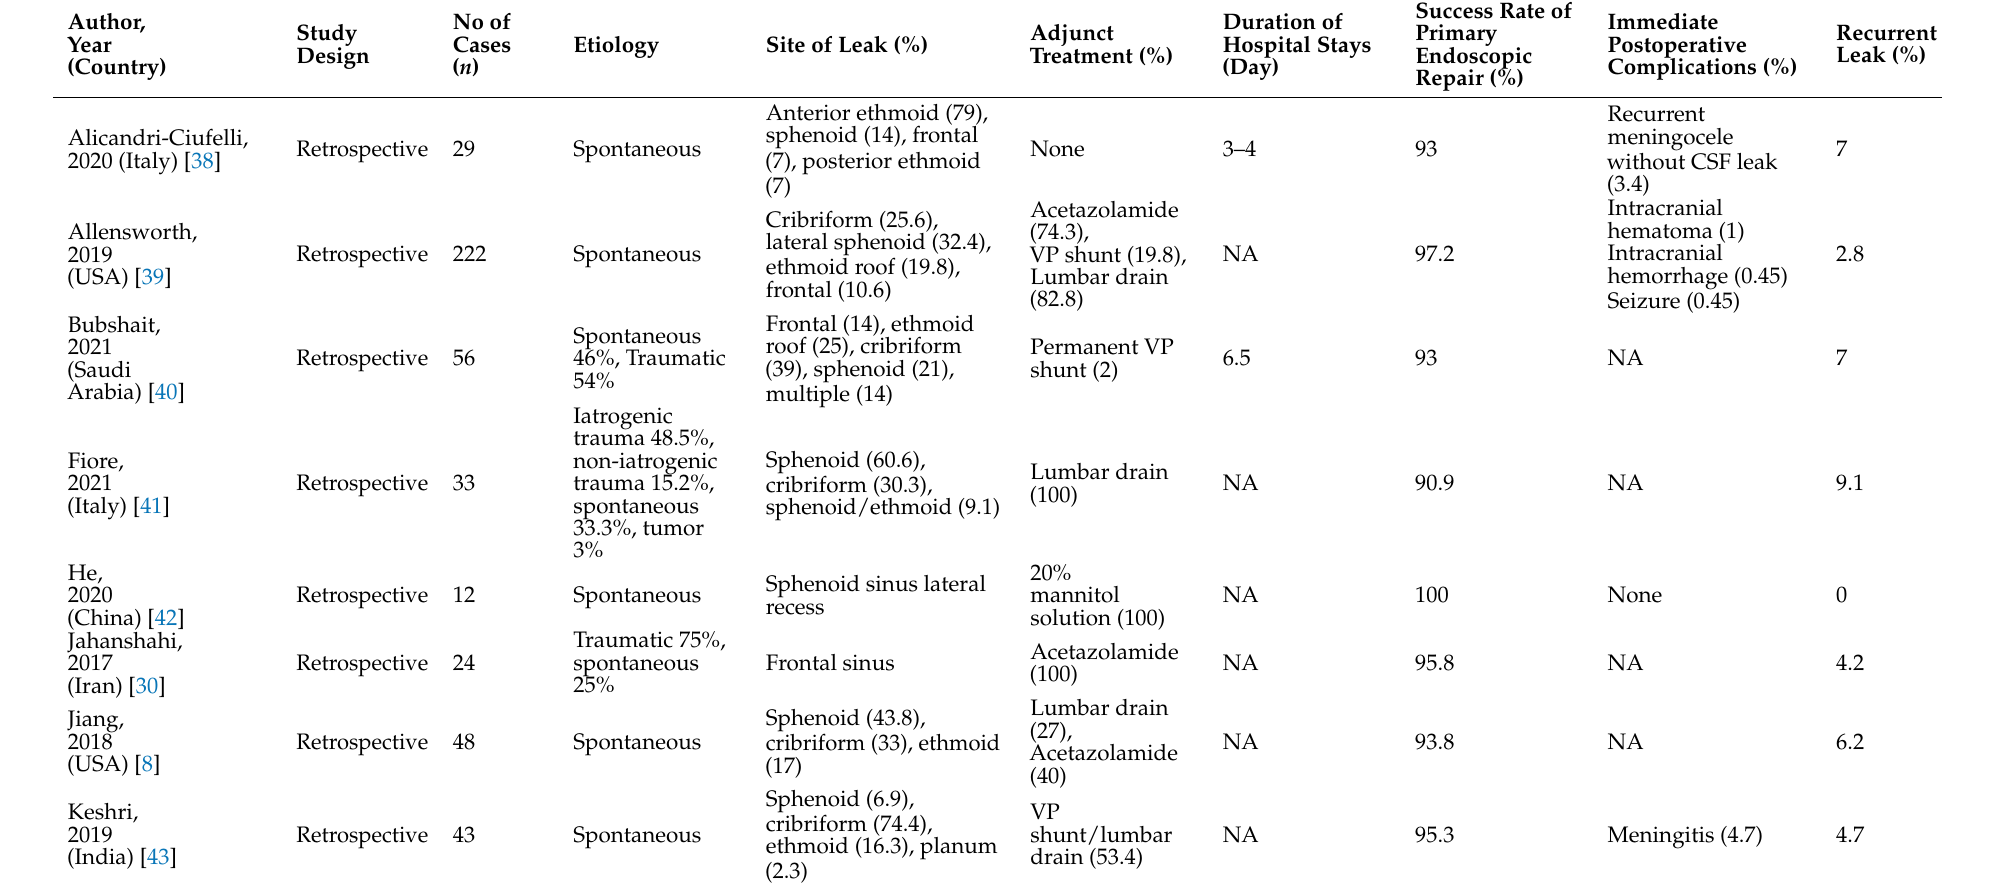
Table 6. Summary of recent studies on the main outcomes of the primary endoscopic repair of CSF